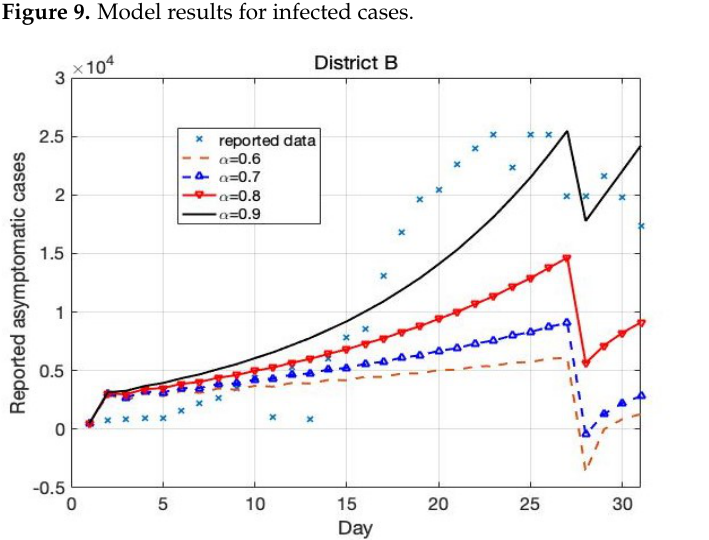
Figure 10. Model results for asymptomatic